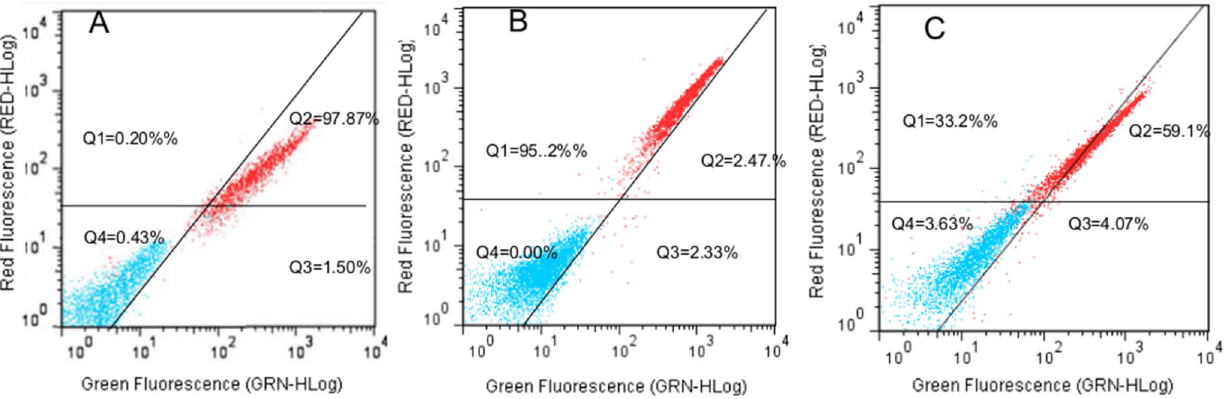
Figure 4. FCM analysis of S.cerevisiae S288C cells stained with FUN-1. Green fluorescence intensity is shown on the x-axes and red fluorescence intensity is shown on the y-axes. Dot plot (A) shows the fluorescence of dead cells after staining with FUN-1. Dot plot (B) shows the fluorescence of viable and culturable cells after staining with FUN-1. Dot plot (C) shows the fluorescence of VBNC cells after staining with FUN-1. Red- negative cells are contained in quadrants 3 and 4; Red-positive cells are contained in quadrants 1 and 2. Green- positive cells are contained in quadrants 2 and 3; Green-negative cells are contained in quadrants 1 and 4. Red fluorescence was measured at 630 nm (emission) and Green at 525 nm (emission). One representative experiment of the three performed is shown.